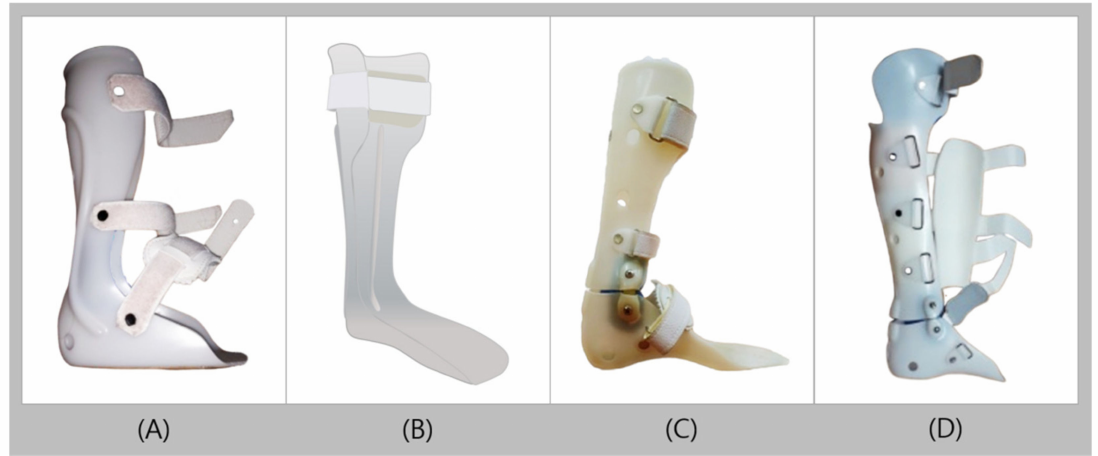
Figure 1. Types of plastic ankle-foot orthoses ( A ): solid ankle-foot orthosis, ( B ): posterior leaf spring orthosis, ( C ): hinged ankle-foot orthosis, and ( D ): patellar tendon-bearing ankle-foot